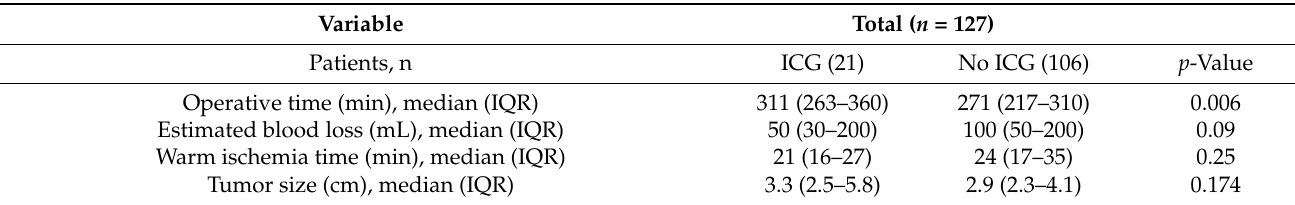
Table 2. Intraoperative and postoperative data of